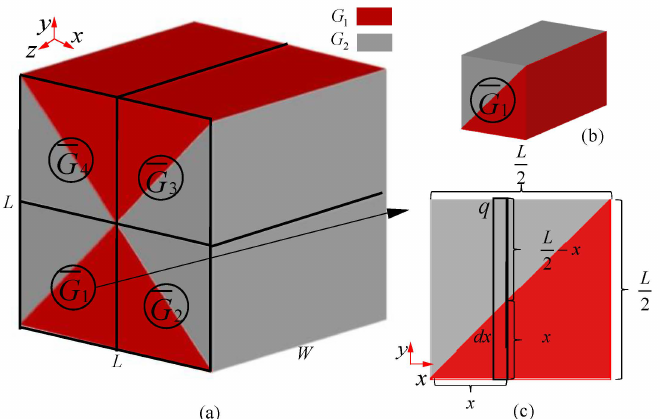
Figure 7. Group concept of macro equivalent shear modulus for multi-layer BCC lattice structures (H = B): ( a ) the whole model; ( b ) the first part; ( c ) the representative unit calculation in x - y